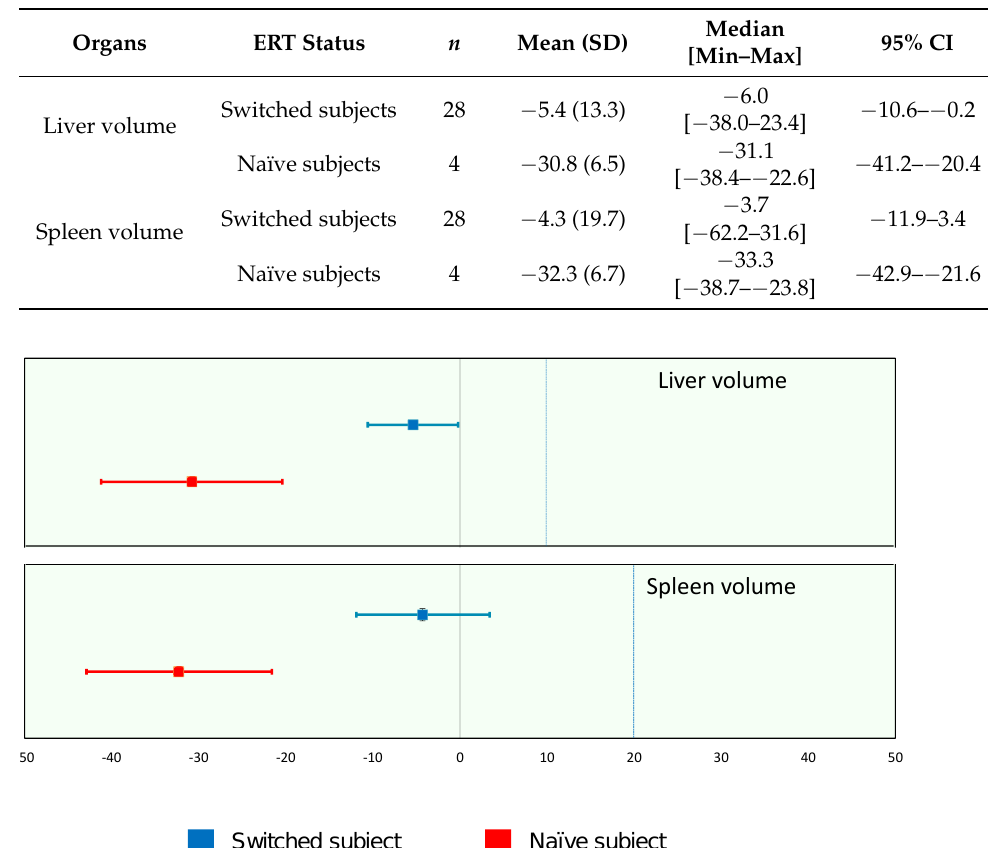
Table 2. Liver and spleen volumes (updated from [14,15]).